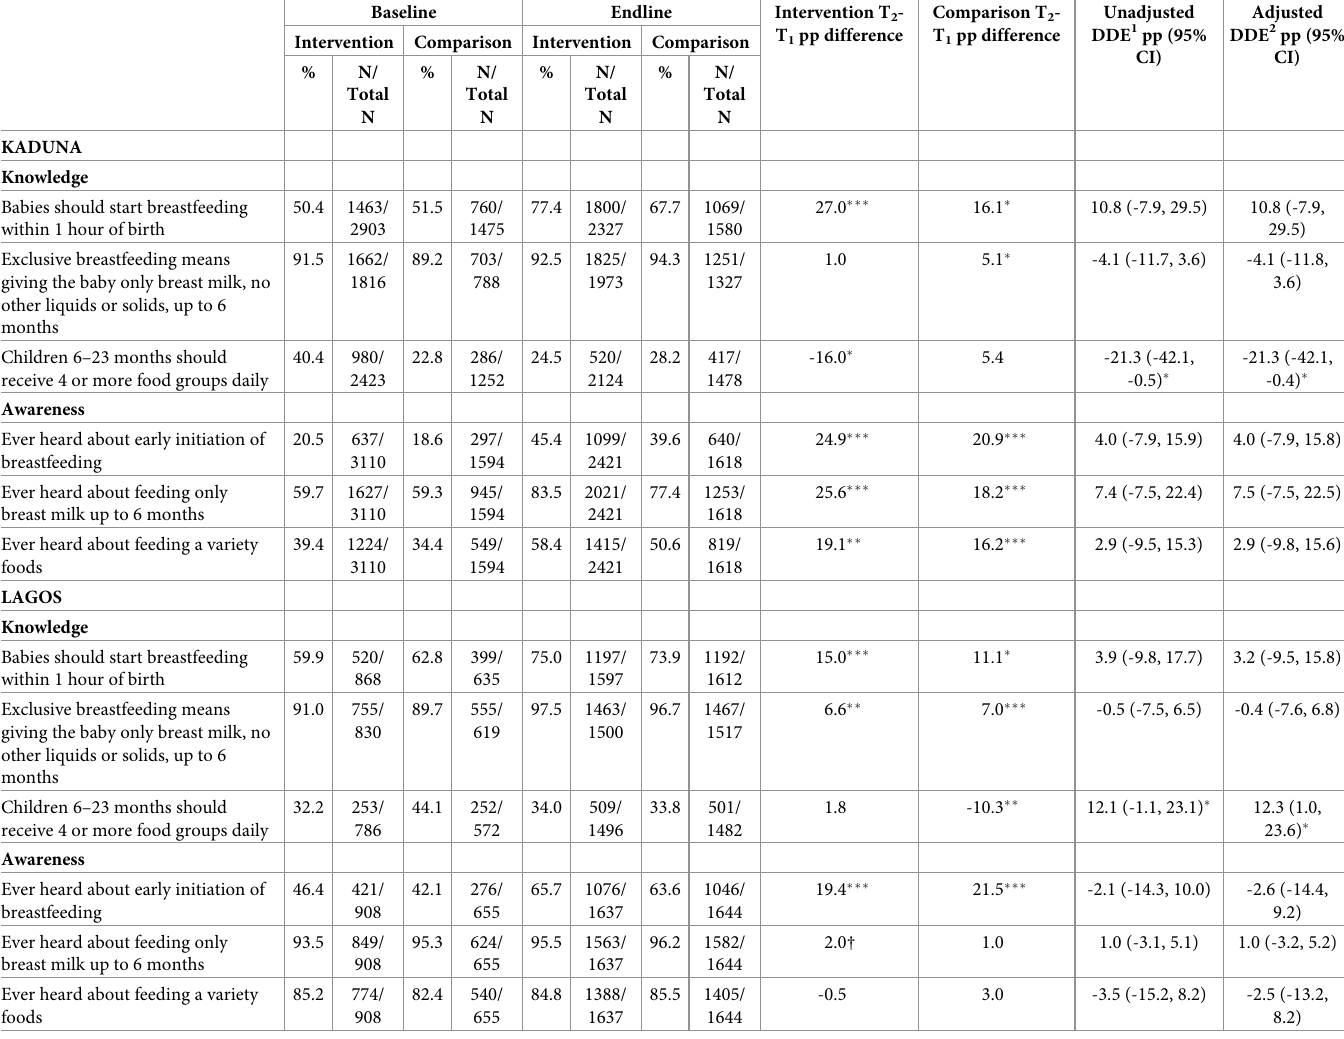
Table 3. Impact of Alive & Thrive on mothers’ knowledge and awareness of key IYCF practices in Kaduna and Lagos States, Nigeria. Baseline Endline Intervention T 2 - T 1 pp